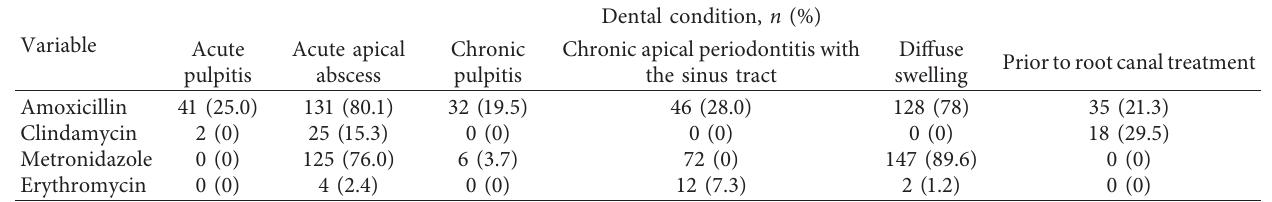
Table 3: Prescribing pattern of antibiotics under different conditions.